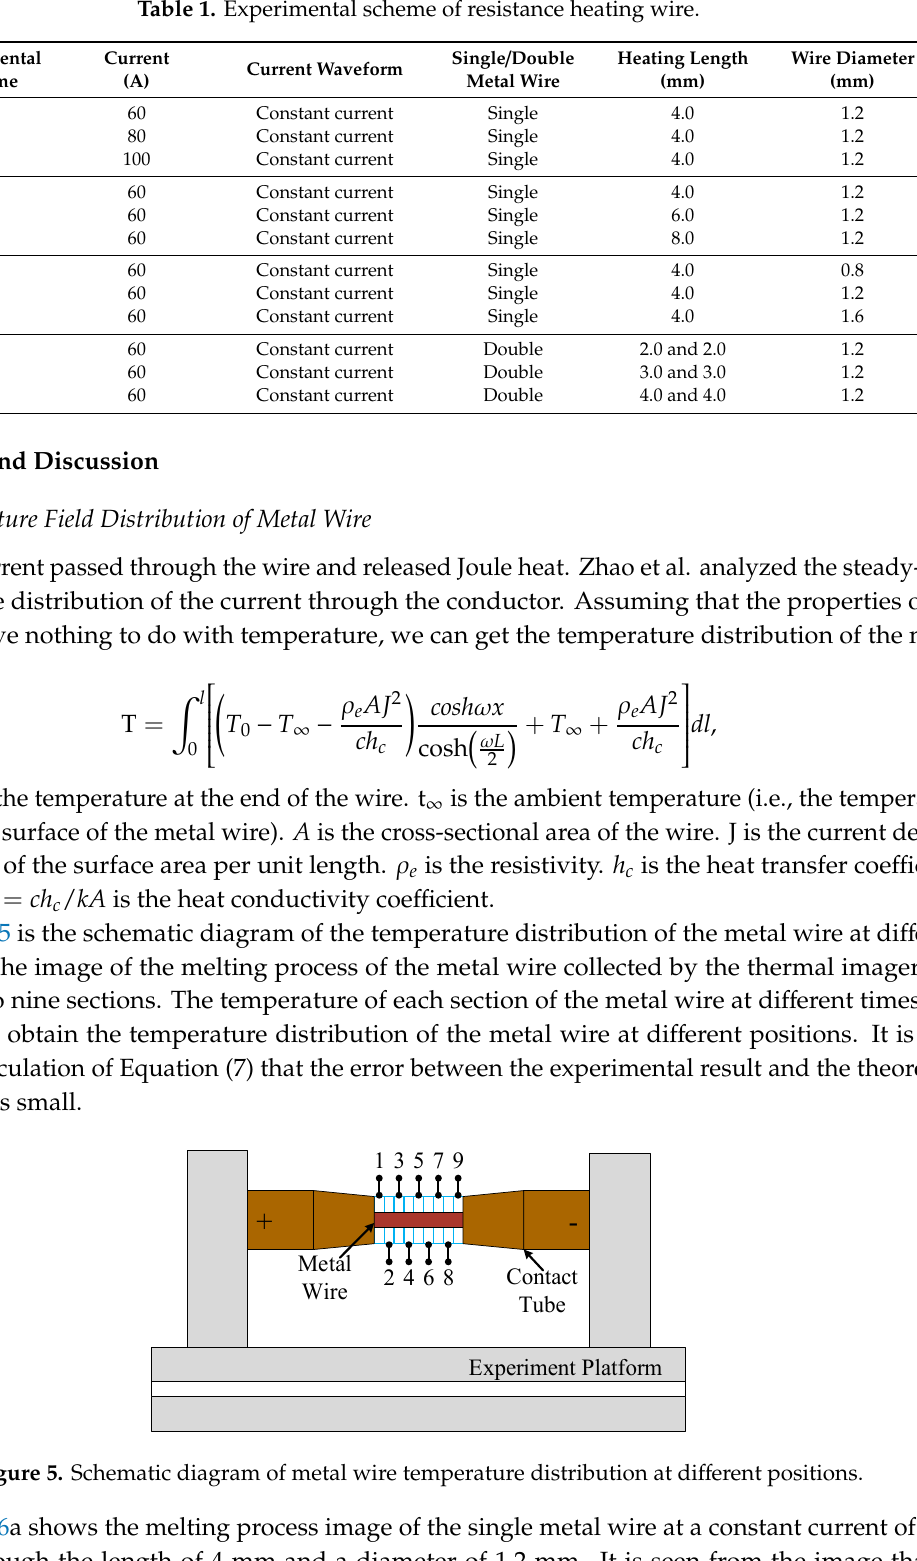
Table 1. Experimental scheme of resistance heating wire.